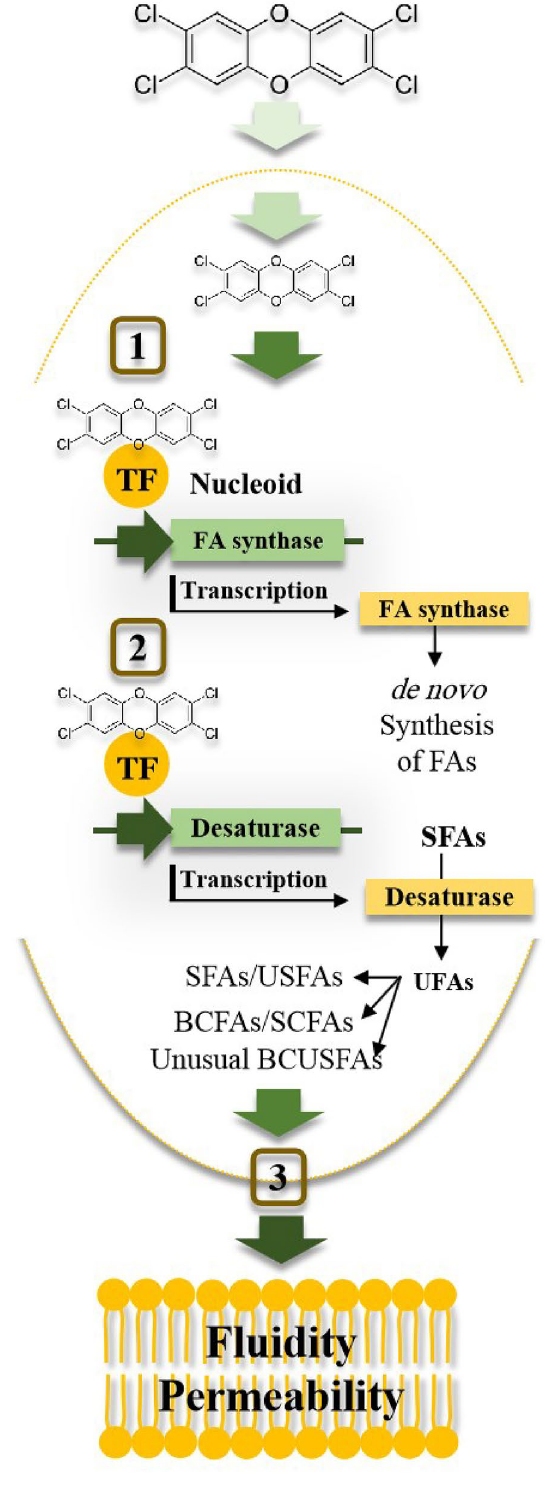
Fig. 1 Schematic model of molecular and biochemical impacts of dioxins on lipid biosynthesis and cell membrane composition in soil microorganisms. Due to their extreme lipophilicity, dioxins show a high affinity towards cellular lipids. After their uptake, dioxins can affect the metabolism of microbial FAs by two distinct and mutually exclusive UFA biosynthetic pathways in bacteria, an anaerobic and an aerobic pathway. (1) The first is used by anaerobes and some facultative aerobic microorganisms leading to produce UFAs by de novo synthesis under the action of an FA synthase. (2) The other produces only saturated FAs, via multisubunit associated-membrane desaturases. This generally modifies the composition of cellular FAs leading to decreasing ratios of saturated FAs/unsaturated FAs (SFAs/ USFAs), branched-chain FAs/straight chain FAs (BCFAs/SCFAs). It also leads to the generation of an unusual FAs such as branched-chain unsaturated FAs (BCUSFAs), which enhances the fluidity and permeability of the cell membrane. The spectrum of unusual FAs produced as part of dioxin responses in these bacteria gives rise to specific “lipidic signatures” that can be used as part of diagnostic and remediation strategies to address such environmental pollutants